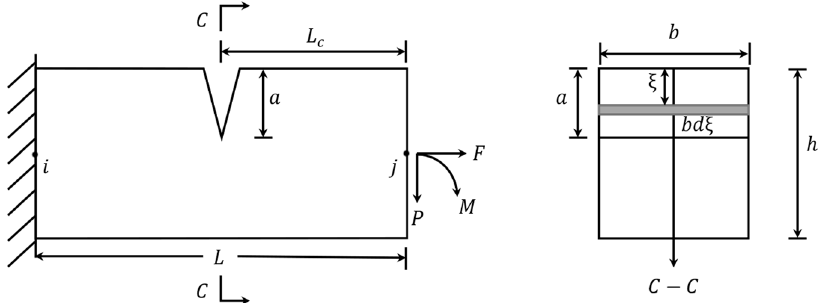
Figure 4. Open cracked beam element.